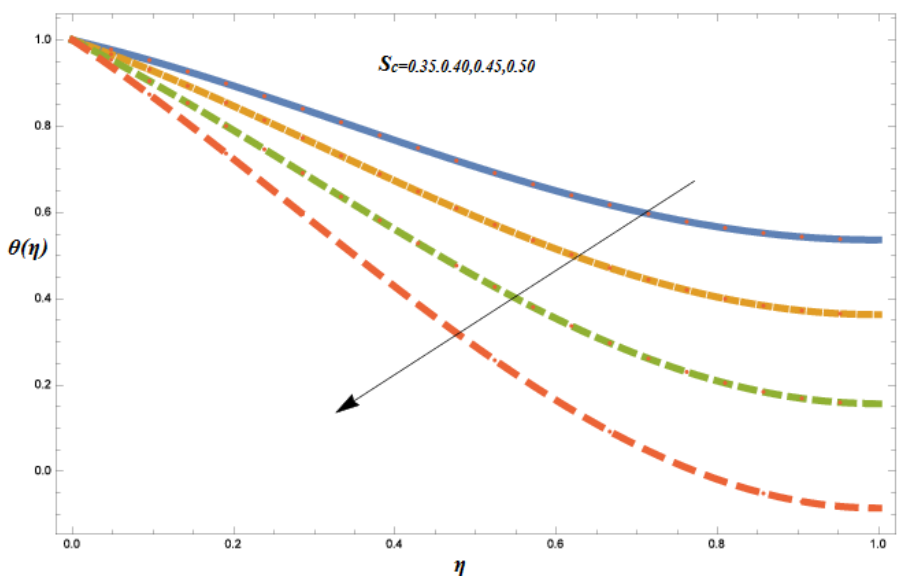
Figure 17. The variation of temperature scale gradient θ ( η ) for different values of S c , when (cid:125) = − 0.25, S = 0.7, B r = 0.7, N r = 0.7, P r = 10, D u = 0.7, ε = 0.7, S r = 0.7, λ = 0.7, Λ = 0.7, β = 1.